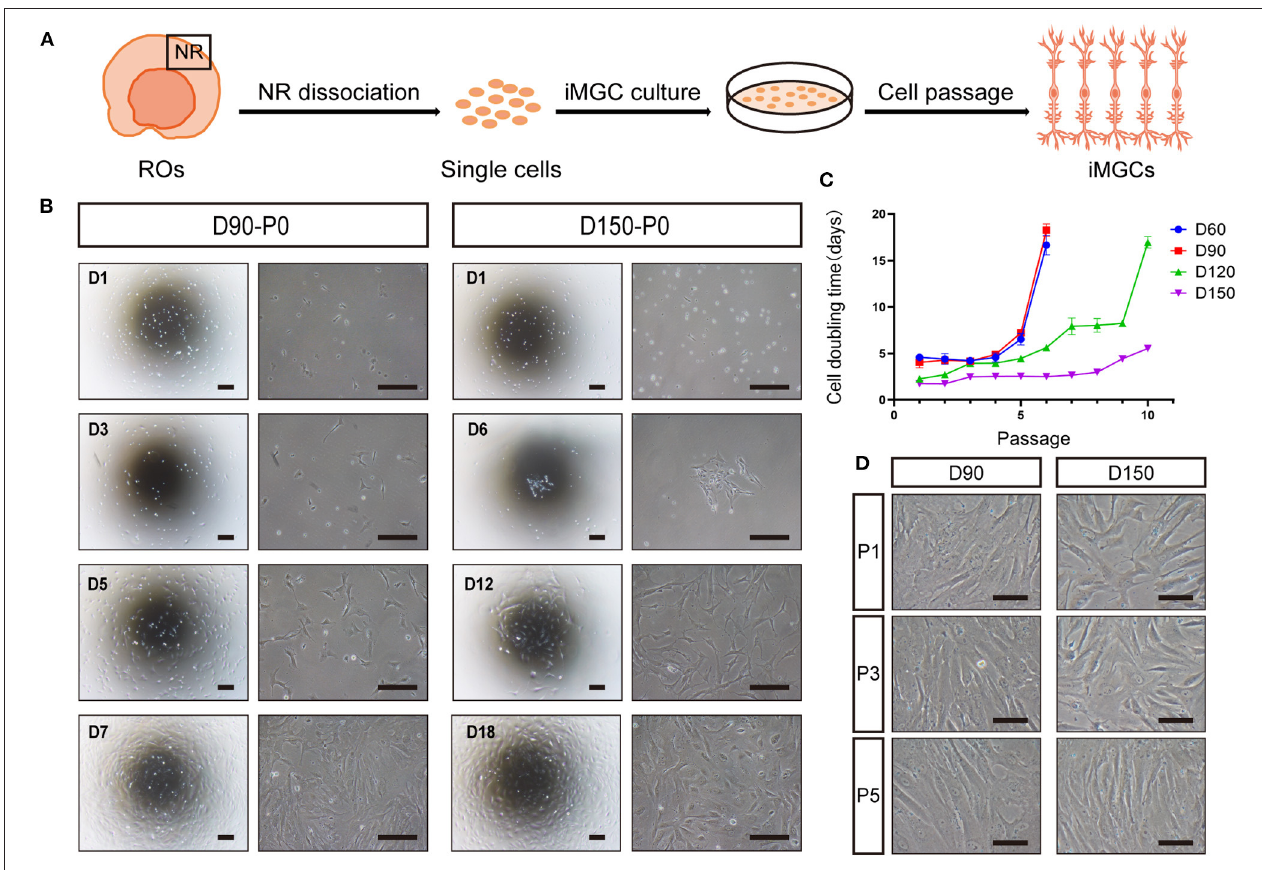
FIGURE 3 | Optimal expansion of induced MGCs (iMGCs) from hiPSC-derived ROs. (A) Schematic diagram of expansion of iMGCs from hiPSC-derived ROs. (B) Bright-field images showed the distinguished morphological features of the passage 0 (P0) cells isolated from D90-ROs (D90-P0) and D150-ROs (D150-P0). (C) The cell doubling time showed different expansion capability of cells isolated from D60-, D90-, D120-, and D150-ROs. (D) Bright-field images showed no obvious morphological difference in P1, P3, and P5 cells expanded from D90- and D150-ROs, all appearing a spindle-like shape. ROs, retinal organoids; NR, neural retina. Scale bars = 200 µ m (B) and 100 µ m (D)